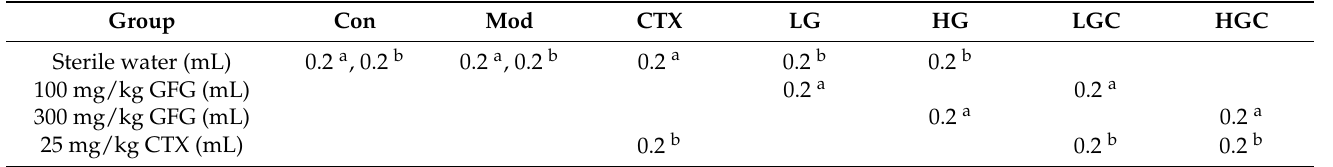
Table 1. Experiment grouping and treatment